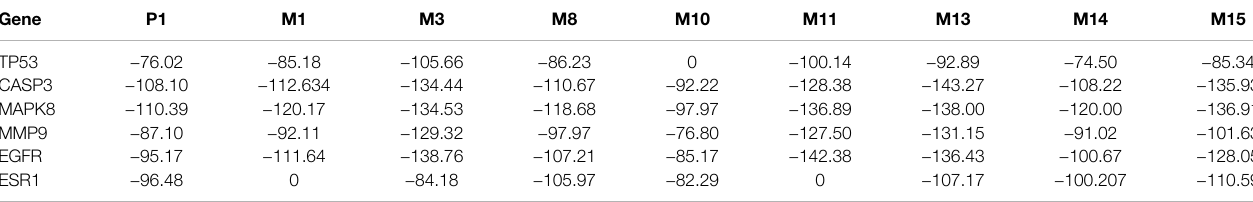
TABLE 1 | Molecular docking